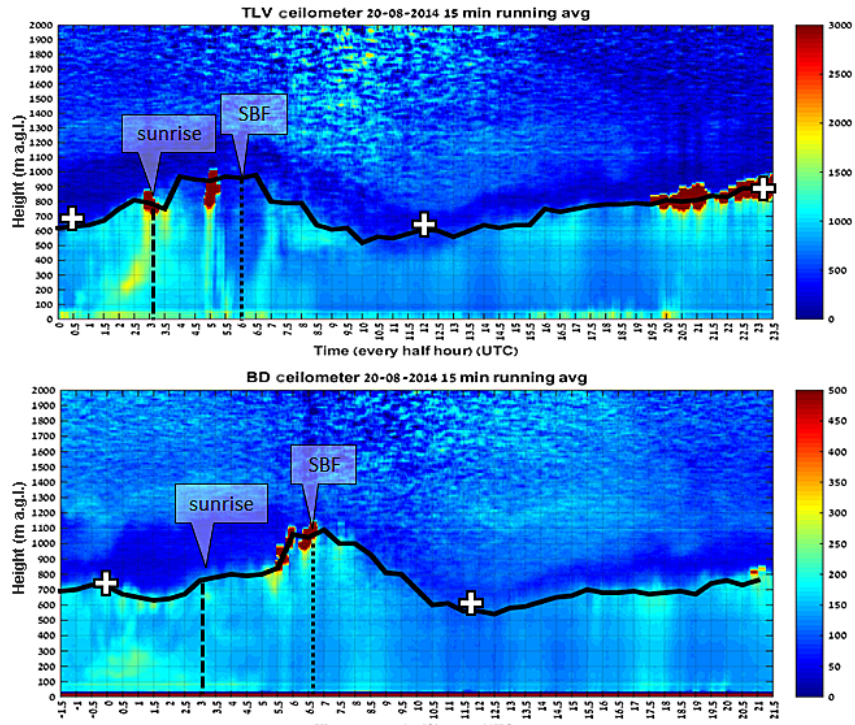
Figure 4. Diurnal MLH (solid black line) on 20 August 2014 for BD and TLV. The MLH is plotted on the half-hourly averaged plots of attenuated backscatter (units 10 − 6 m − 1 sr − 1 ) . The BD plot is shifted by 2h to coincide with UTC time. The plot includes indications of the sunrise, the SBF entrance time, and the MLH based on the 00:00 and 12:00UTC radiosonde profiles in the BD site (indicated by the white